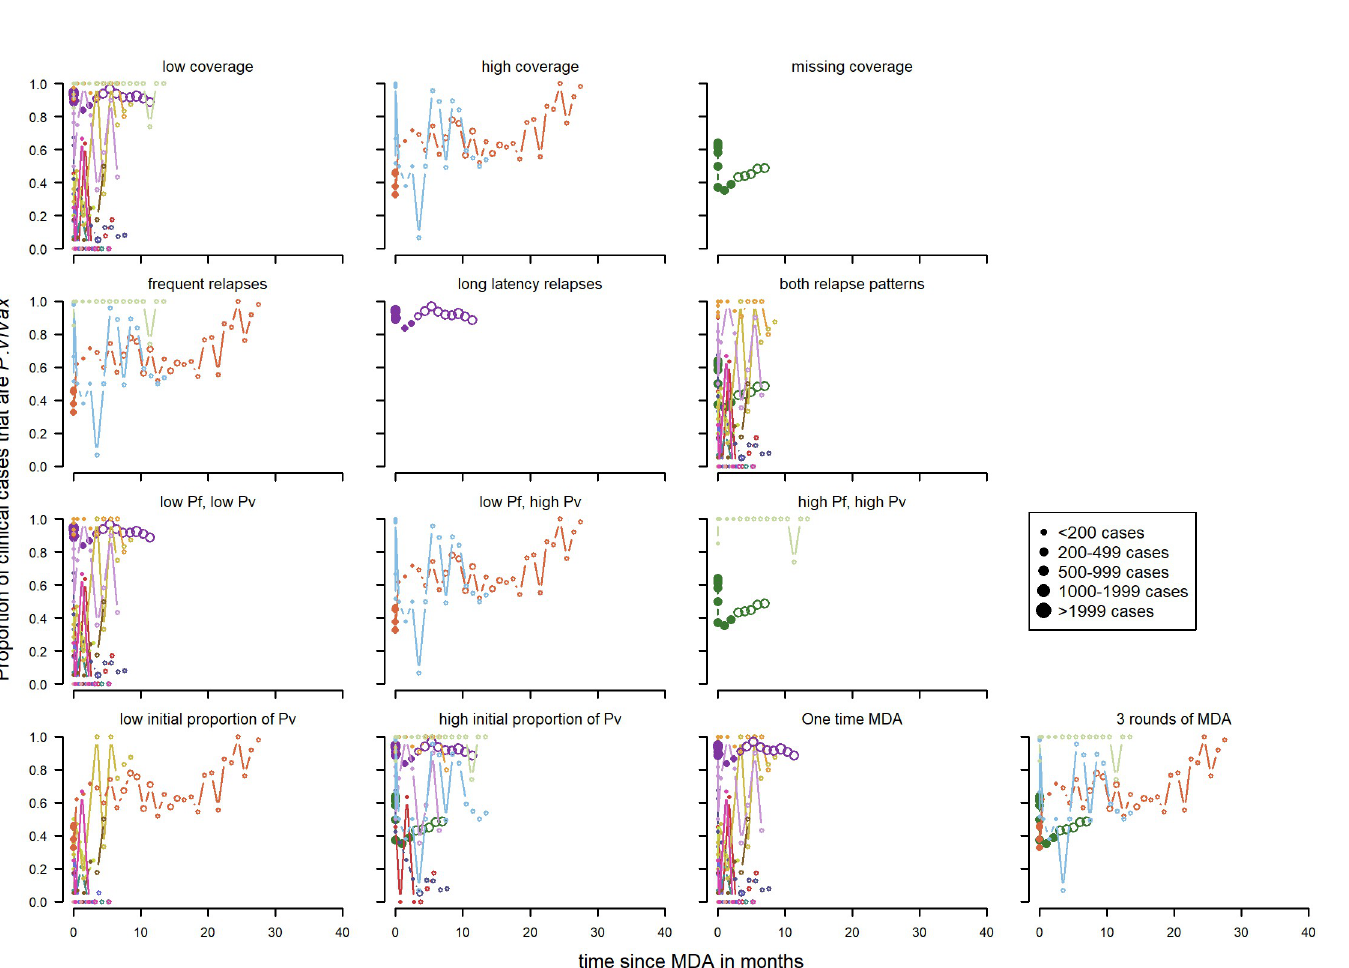
Fig 15. Spaghetti plots splitting the series of time-points of the proportion of cases with P. vivax infection by rounds of MDA, coverage, relapse pattern and transmission intensity after MDA. Dot size depending on number of